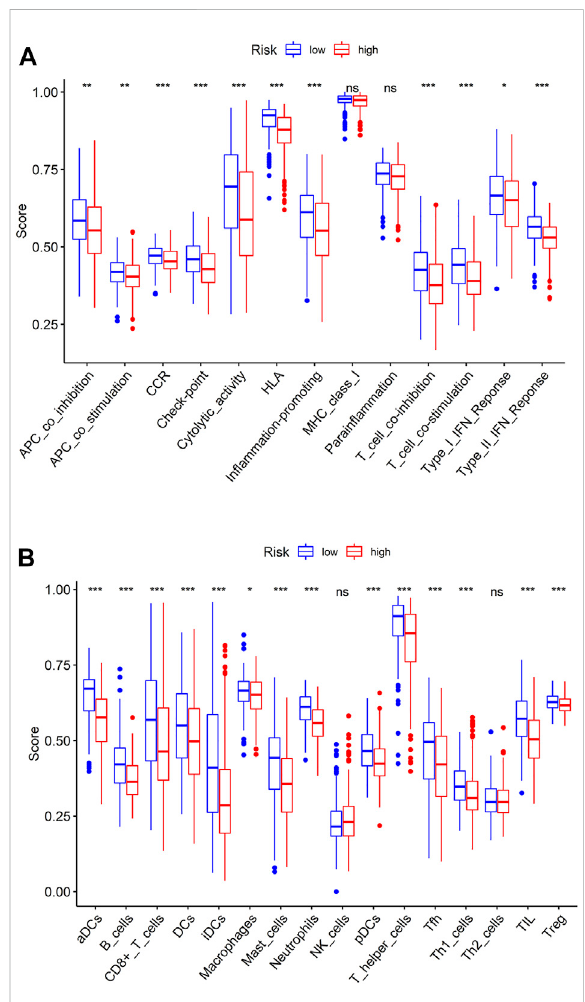
FIGURE 5 ssGSEA in high- and low-risk groups. (A) Immune-related gene sets in high- and low-risk groups; (B) Boxplotof immunecell differences in the two risk